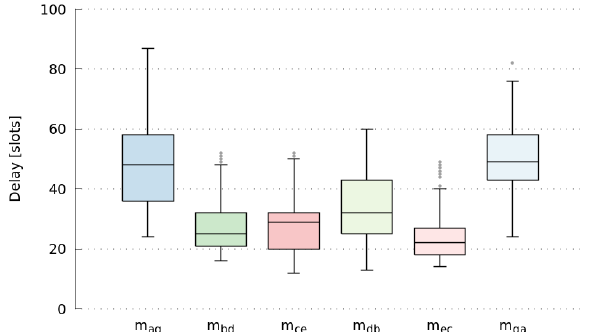
Figure 6. End-to-end message